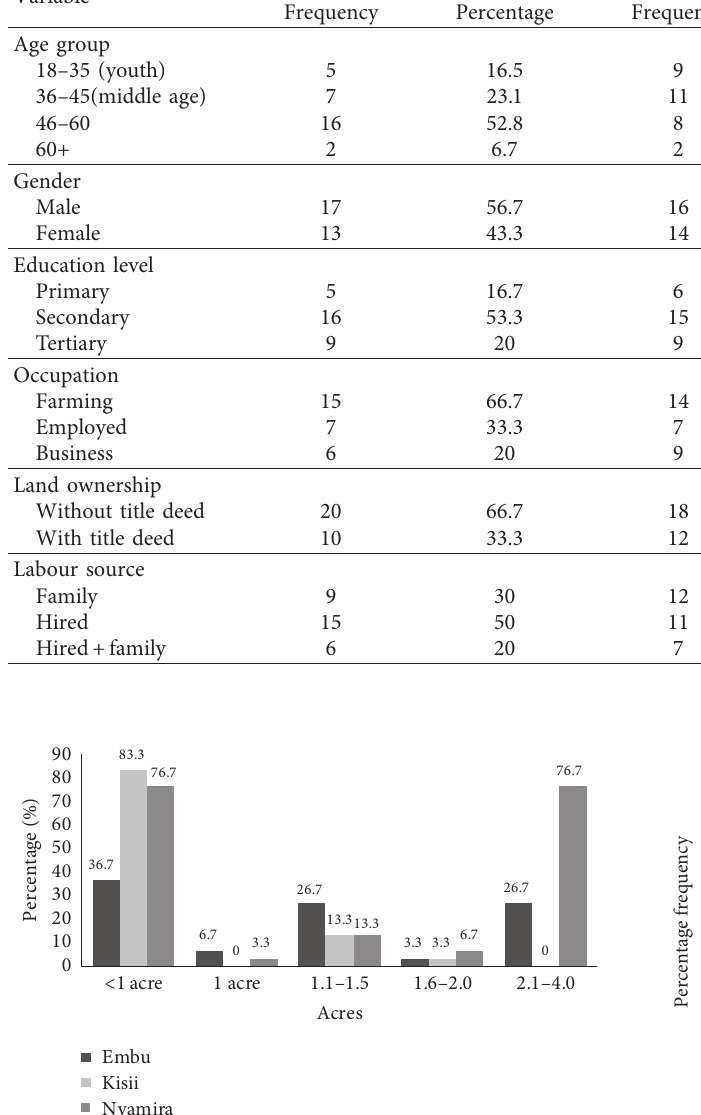
Figure 2: Land size of farmers in Kisii, Nyamira, and Embu counties.